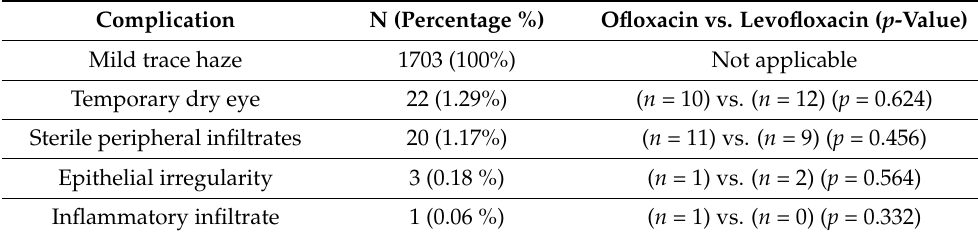
Table 2. Postoperative complications of Corneal